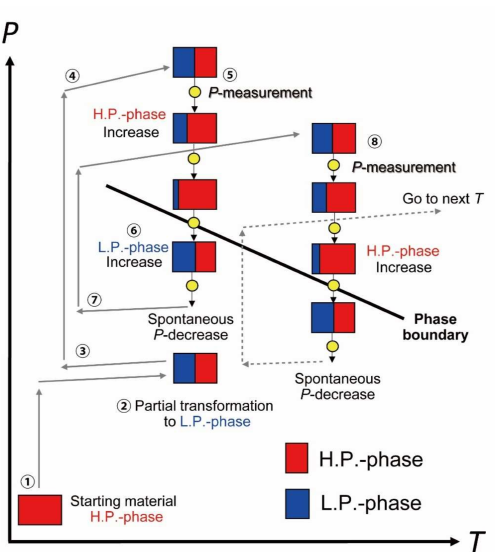
Figure 4. A schematic drawing explaining the novel strategy to determine a phase boundary ac- curately and precisely. The pressure spontaneously and gradually decreases while keeping the temperature and press load constant. In the H.P.- and L.P.-phase stability fields, the H.P.- and L.P.- phases increase with time, respectively, enabling the bracket of the phase boundary. The numbers in the circles indicate the steps in the novel strategy explained in Section